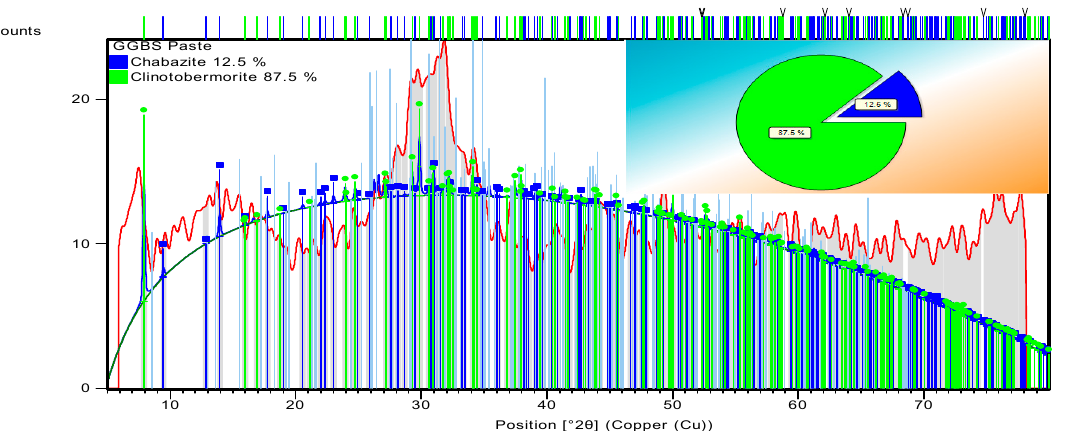
Figure 16. XRD of GGBS paste at 7th days of ambient-curing.